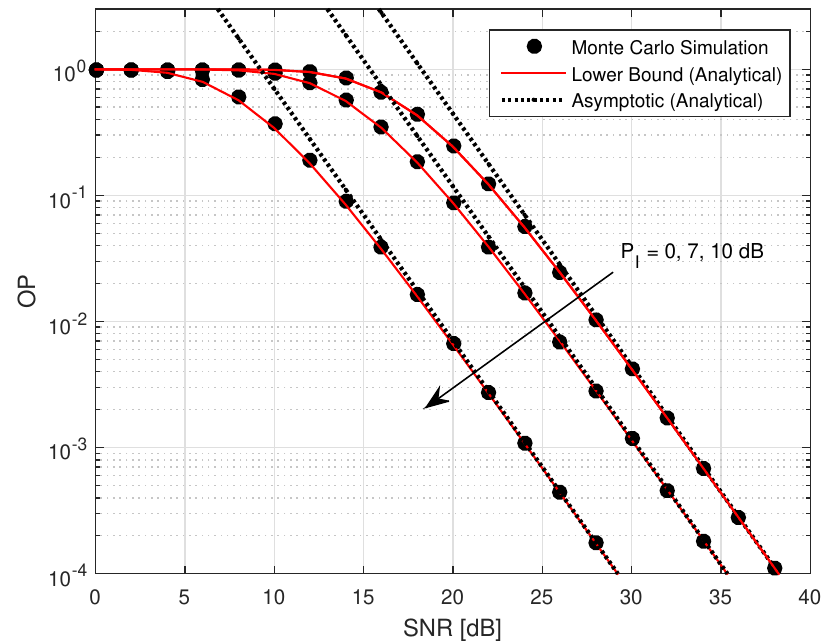
Figure 5. System outage probability with different values for the constant interference power, γ th = 0 dB and L 1 = L 2 =